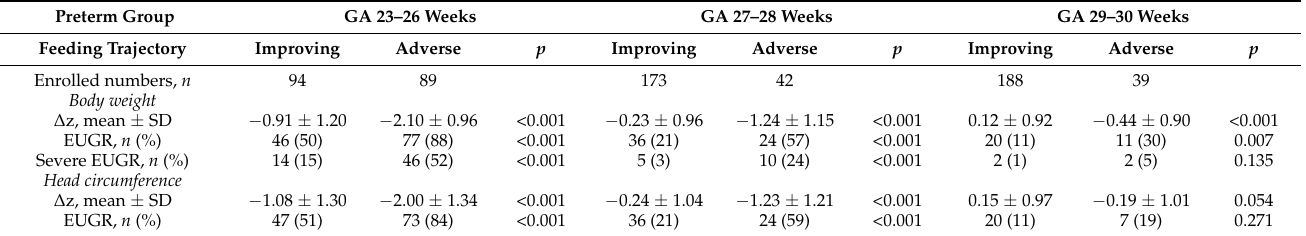
Table 3. Differences in the rates of EUGR in terms of body weight and head circumference between the two feeding patterns in infants in each gestational age preterm group.